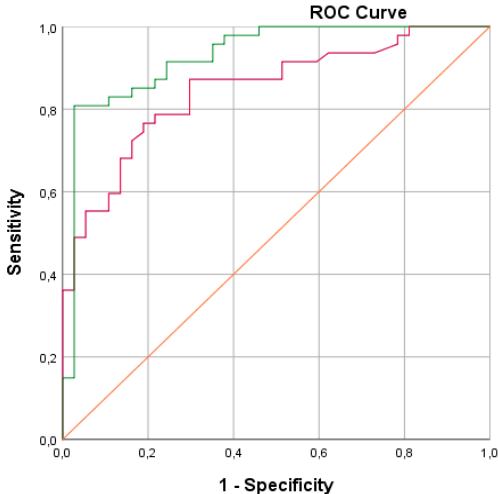
Figure 3. The ROC ( receiver operating characteristic ) curve depicting the different sensitivities and specificities with altered thresholds of both the best fit of data for cross validation (red line). Black line represents the line of no ‐ discrimination. The area under the curve is 0.86.